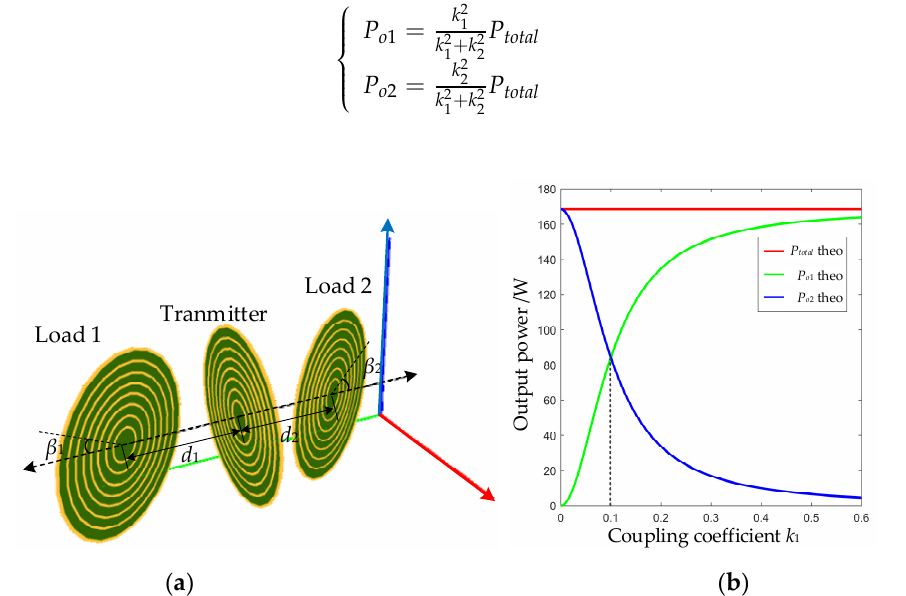
Figure 8. Schematic diagram of power distribution when k 1 ≠ k 2 : ( a ) Loads position; ( b ) power distribution when k 1 changes and k 2 = 0.1 is fixed.